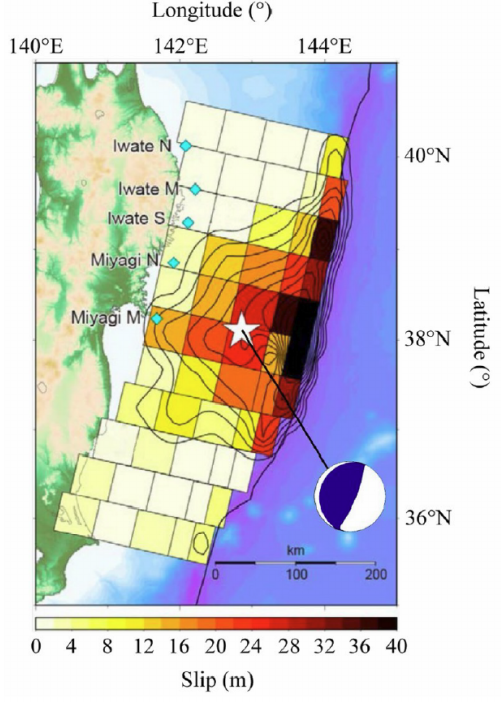
Figure 2. Fujii–Satake model ver. 8.0 (adapted from Kotani et al., 2020).